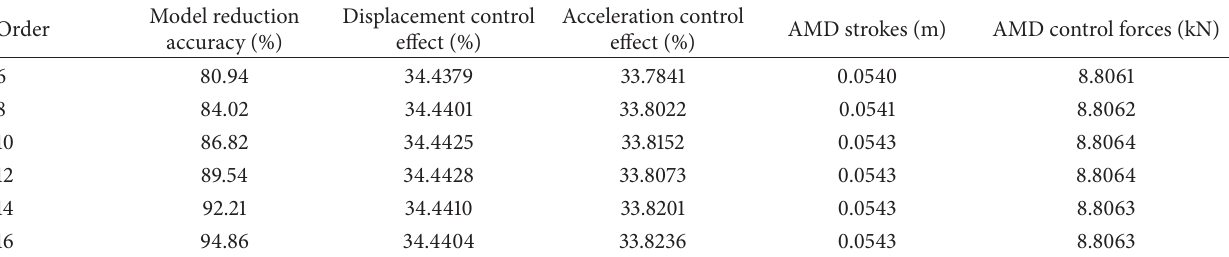
Table 3: Comparison of the performances of control system under different